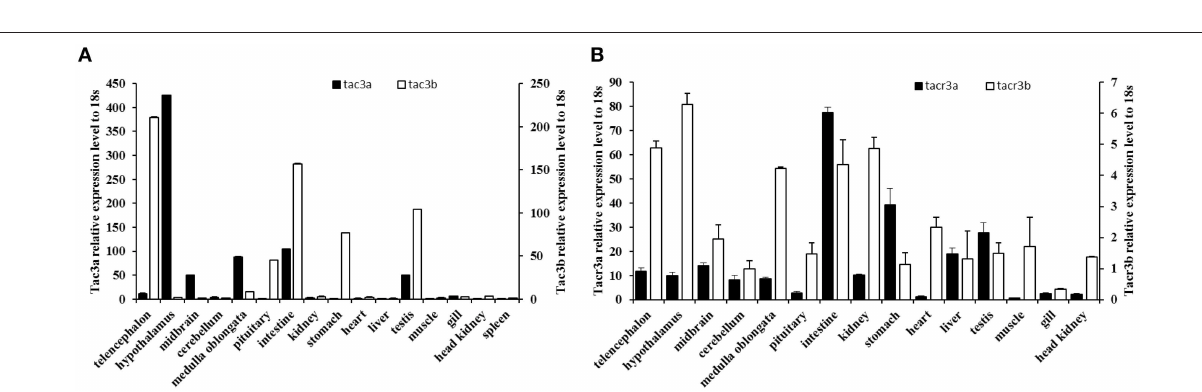
FIGURE 5 | Expression of tac3s (A) and tacr3s (B) mRNAs in various tissues (telencephalon, midbrain, hypothalamus, cerebellum, medulla oblongata, pituitary, gill, liver, intestine, stomach, spleen, heart, kidney, head kidney, muscle, and testis) of male spotted sea bass. The X axis indicates different tissues. The results are normalized to 18S RNA. The data are shown as the mean ± S.E.M ( n = 3) and the mRNA levels of tac3a and tac3b were calculated as fold change relative to the mRNA levels of the heart and spleen, respectively, while the mRNA levels of tacr3a and tacr3b were calculated as fold change relative to the mRNA levels of the heart and pituitary,